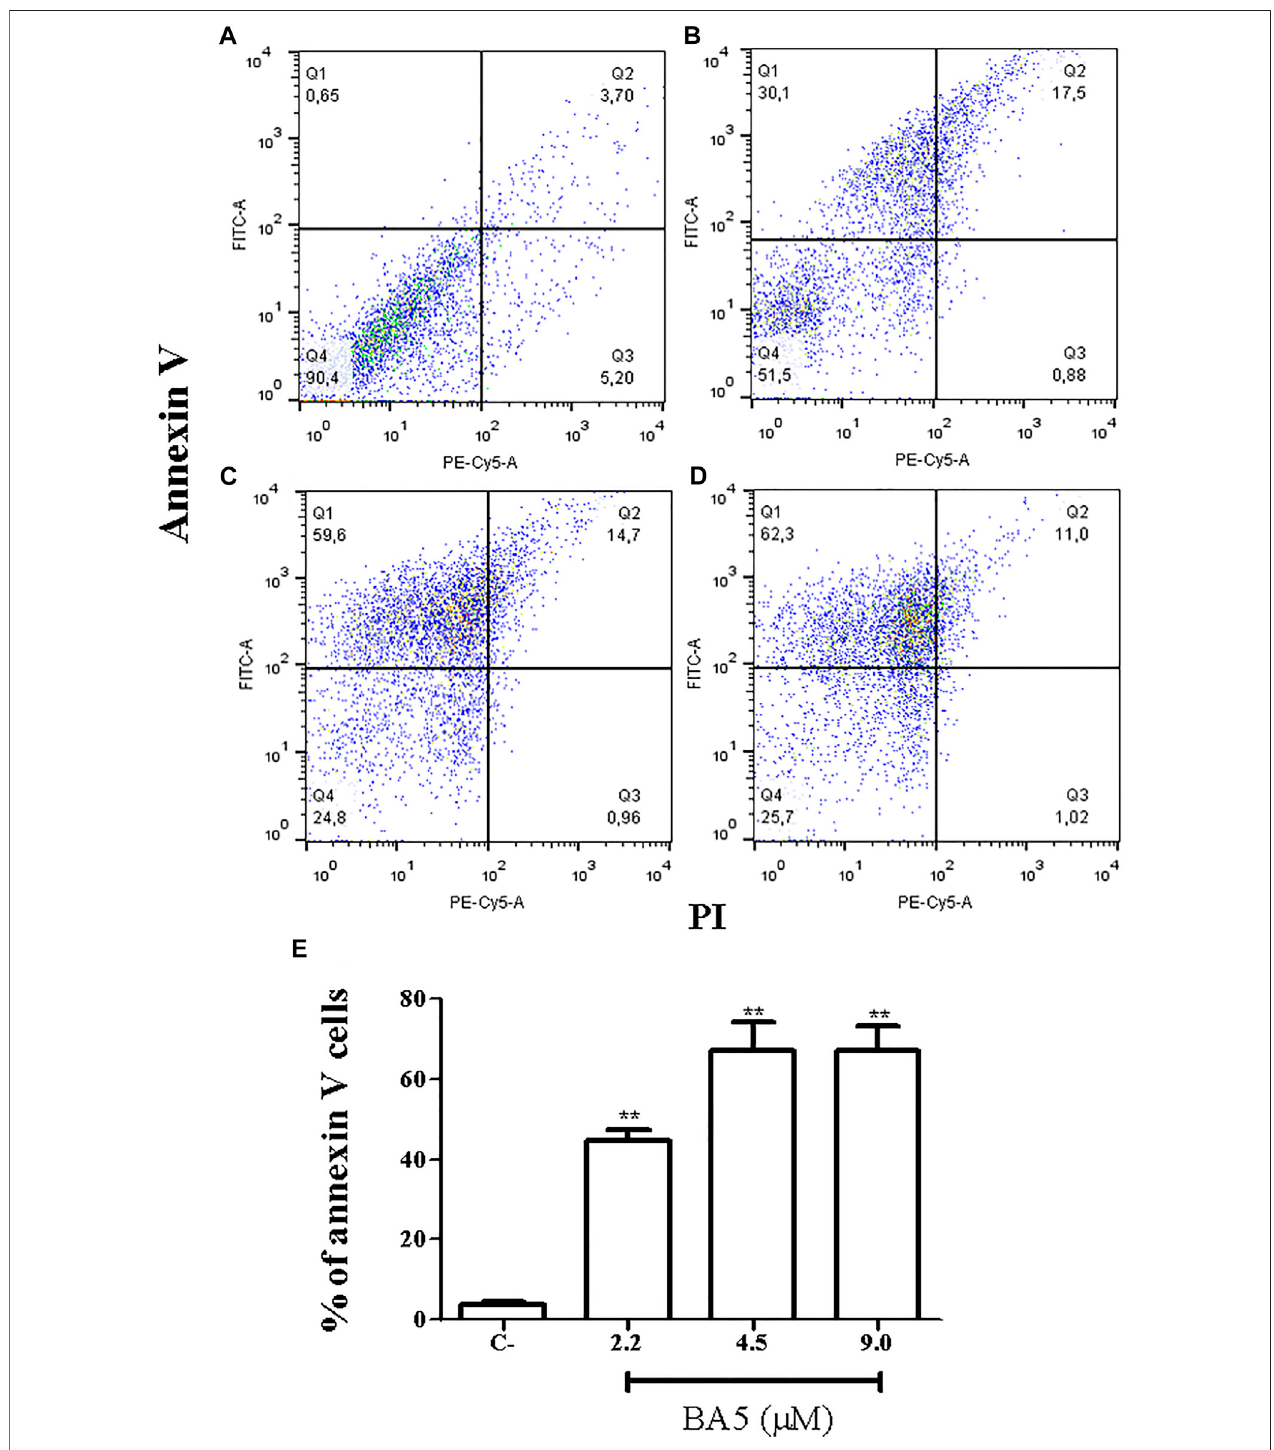
FIGURE 4 | Flow cytometry analysis of cell death pattern. L. amazonensis promastigotes were treated with BA5 and incubated with propidium iodide (PI) and annexin V after 48 h of incubation. (A) Untreated promastigotes (B) promastigotes treated with 2.2 µM of BA5 (C) promastigotes treated with 4.5 µM of BA5 (D) promastigotes treated with 9.0 µM of BA5 (E) Percentage of stained cells for annexin V after 48 h of treatment with BA5. Values represent the means ± S.E.M. of three determinations obtained in one of two experiments performed. ** p < 0.01 compared to stimulated and untreated cells.